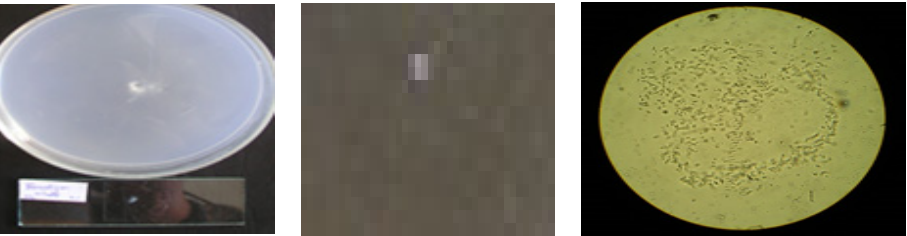
Table 3. The macroscopic observations on the degree of development of fungal mycelium on APDMS-CL .